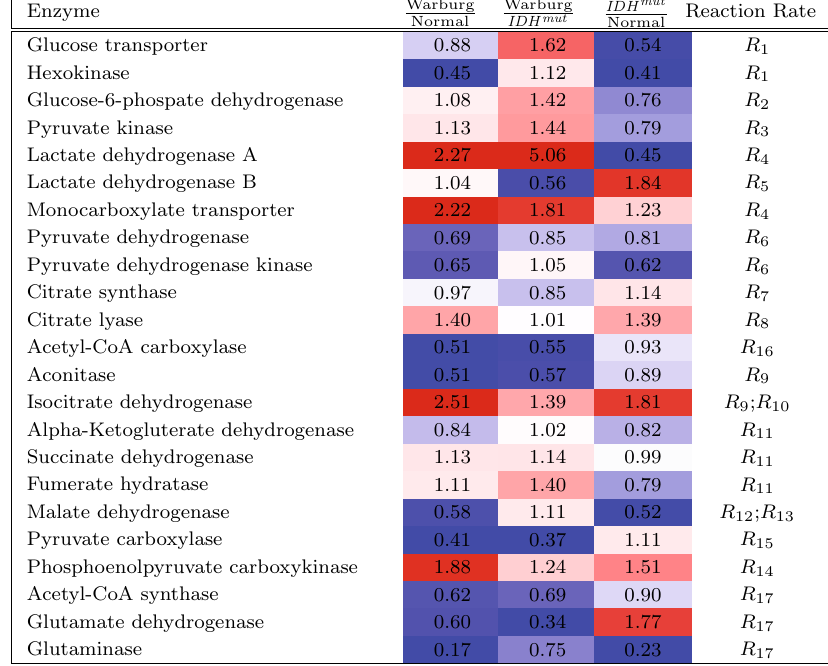
Table 1. Fold change of metabolic enzymes expression by phenotype Gene expression data from TCGA cohorts were aggregated at the enzyme/functional category level, and differential expression analysis was performed to assess the relative differences in the patient sample cohorts of GBM IDH wt, LGG IDH mutant, and Normal brain. These fold changes were used as the estimated relative difference in the reaction rates as